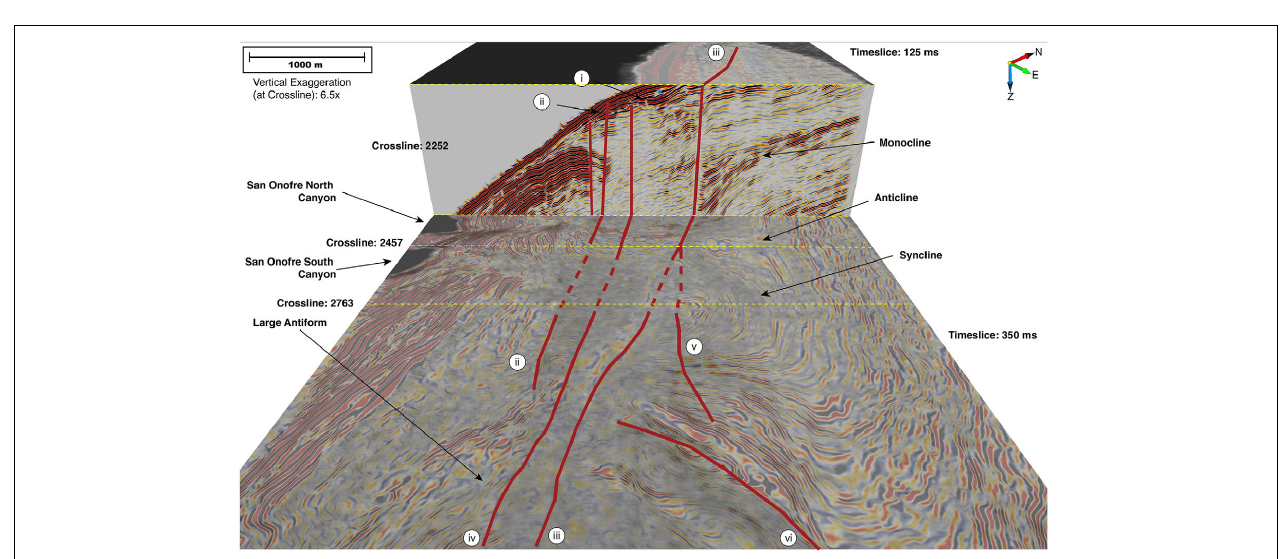
FIGURE 6 | Interpreted stair diagram of crossline 2252. Fault interpretations shown with solid red lines; dashed where interpretations have more uncertainty. Fault fold shown in Figure 5 has been replaced by a monocline terminating at fault segment iii. Yellow dashed lines in lower (350 ms) time-slice represent locations of crosslines shown in other figures. Location relative to the survey area, is shown in Figure 1C